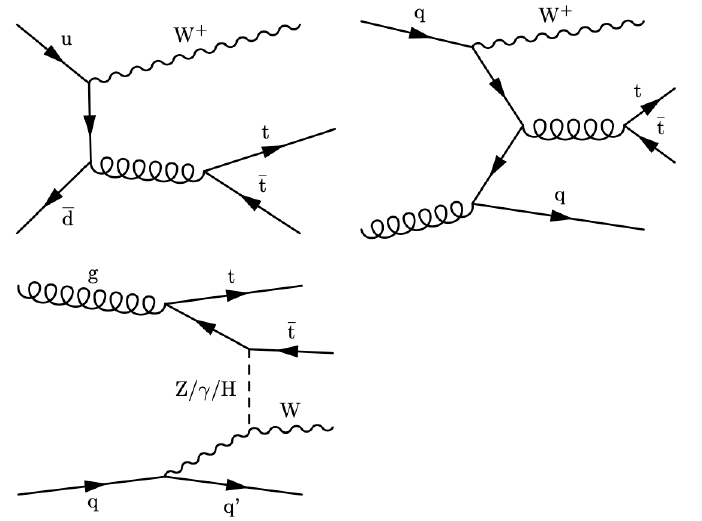
Figure 11. Leading-order (top left) and next-to-leading-order (top right and bottom) Feynman diagram for the t ¯ tW process. The last diagram is an example of the sub-leading electroweak corrections. Calculations at NLO in QCD that account for the next-to-next-to-leading logarithmic (NNLL) [30] effects are now available as well as NLO QCD with NNLL effects with NLO EWK corrections [31,32]. Sub-leading EW corrections ( α 3 α S ) to t¯tW have in fact been found to have a larger effect than expected (approximately 10%) [33–35], primarily due to contributions from amplitudes represented by top-W-boson scattering